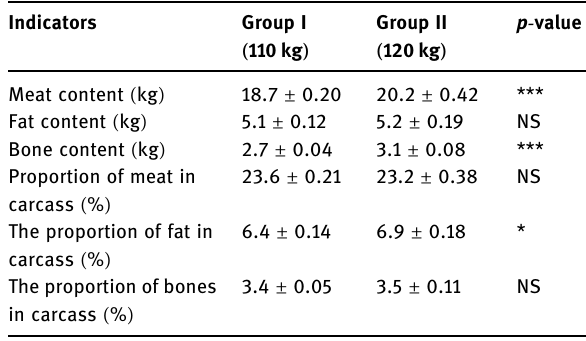
Table 2: Distribution of morphological composition of the cervical - scapular third of the carcass of pigs of the experimental groups ( n = 60 )